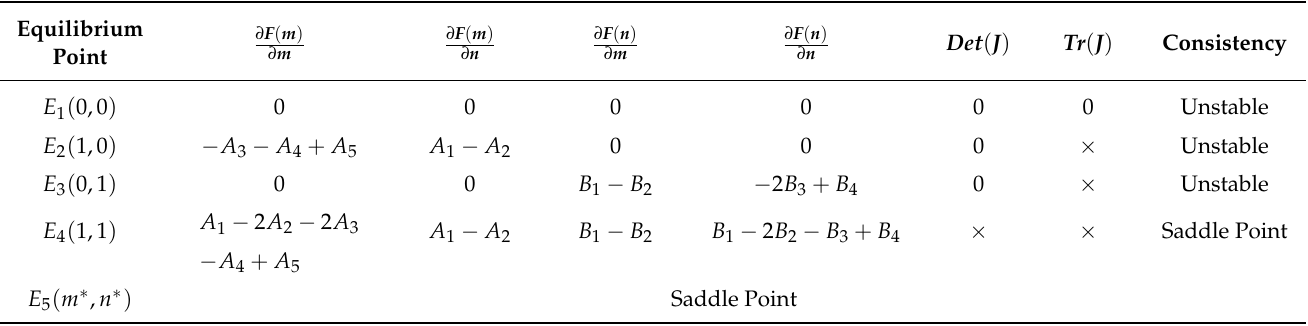
Table 3. Stability analysis of the strategy portfolio under rational government regulators’ and rational energy consumers’